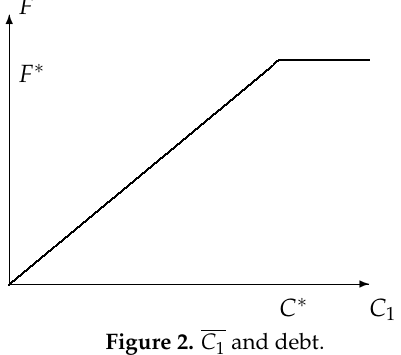
Figure 2. C 1 and